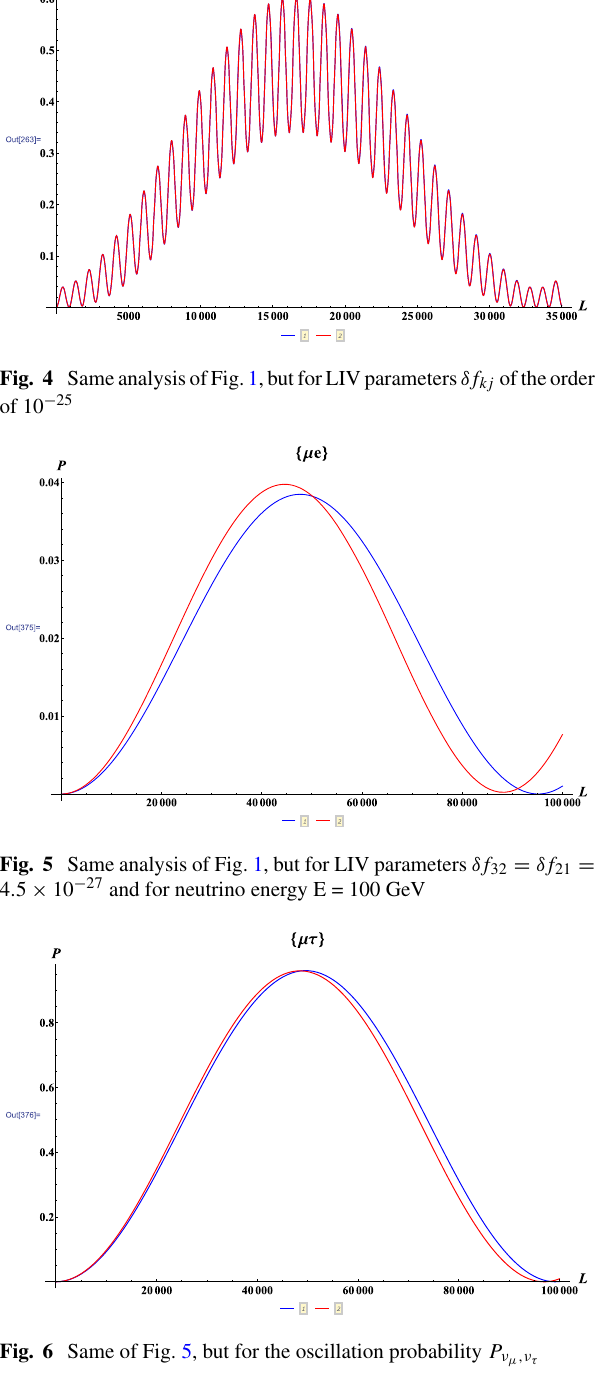
Fig. 6 Same of Fig. 5, but for the oscillation probability P ν μ ,ν τ atmospheric neutrinos by SuperKamiokande and by the neu- trino telescopes. In these graphs we assumed δ f 32 = δ f 21 = 4 . 5 × 10 − 27 , that is of the same order of magnitude derived for the corresponding parameter by SuperKamiokande. For these coefficients values, LIV effects are visible and they induce variations of the oscillation and survival probabili-